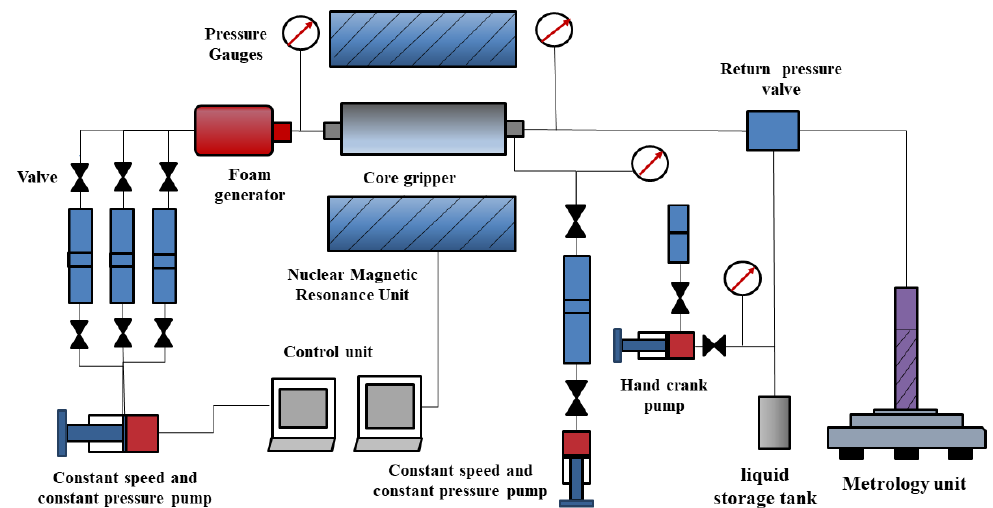
Figure 1. Flow of high temperature and high-pressure online NMR core repulsion experiment.